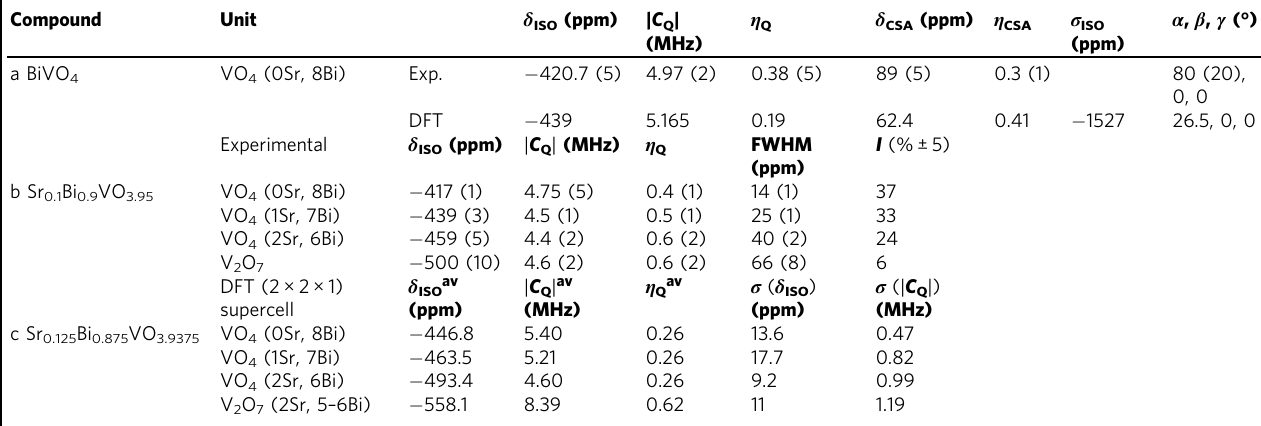
Table 1 51 V NMR parameters